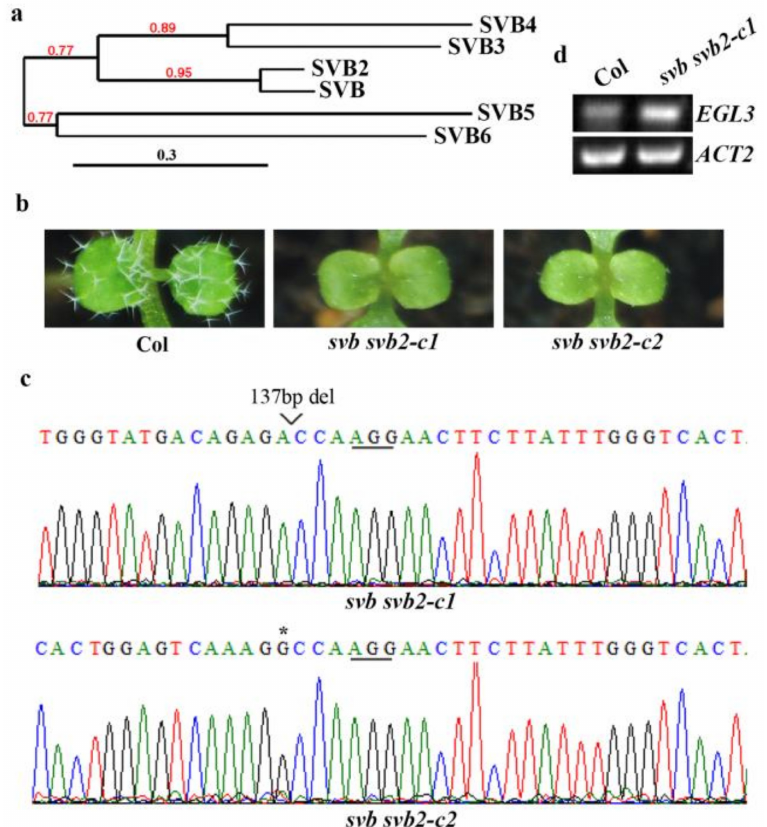
Figure 6. SVB and SVB2 function redundantly to regulate trichome formation. ( a ) Phylogenetic analysis of SVBs. Full-length amino acid sequences of the SVBs were obtained on Phytozome (https: //phytozome.jgi.doe.gov/pz/portal.html#, accessed on 4 June 2021), and used for phylogenetic analysis on phylogeny (http://www.phylogeny.fr/simple_phylogeny.cgi, accessed on 4 June 2021) “One Click” mode with default settings was used for the assays. Bar indicates branch length, and numbers above the branches indicate support values. ( b ) Trichome formation on the first two rosette leaves of the Col wild type and the svb svb2 double mutants. Seeds of the Col wild type, the svb svb2-c1 and svb svb2-c2 double mutants were sow directly into soil pots and grown in a growth room, and trichomes on the first two rosette leaves of 10-day-old seedlings were examined under a Motic K microscope and pictures were taken by using an EOS 1100D digital camera connected to the microscope. ( c ) Editing status of SVB2 in the svb svb2-c1 and svb svb2-c2 double mutants. DNA was isolated from normal flowering T2 plants and used for sequencing. Underlines indicate the PAM sites, star indicates the single nucleotide insertion in the target sequence, and open arrow head indicates the site where a small fragment was deleted. ( d ) Expression of EGL3 in the svb svb2-c1 double mutants. RNA was isolated from 12-day-old seedlings of the Col wild type and the svb svb2-c1 double mutants, and RT-PCR was used to examine the expression of EGL3 . The expression of ACT2 was used as a